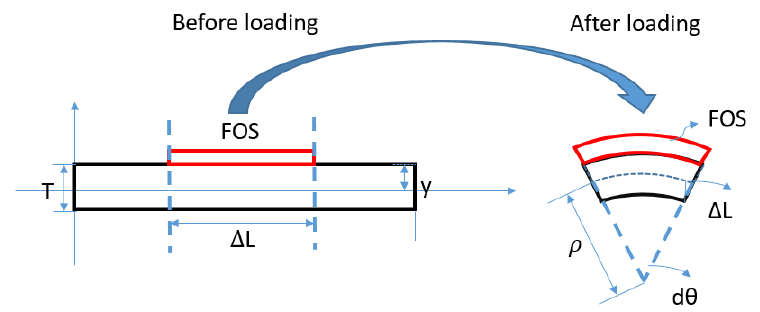
Figure 6. Element before and after loading for continuous fiber optic sensors.